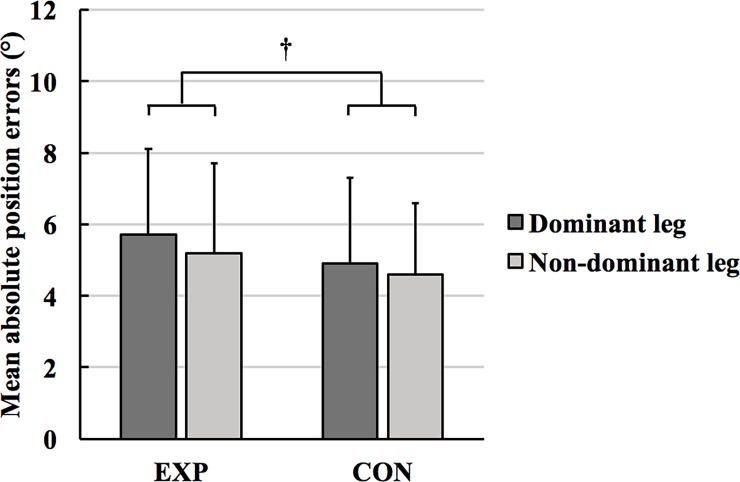
The effects of an above-knee compression garment (CG) on mean absolute position errors at the knee joint.Participants performed a position-matching task more accurately in the Control (CON) condition compared with the Experimental (EXP) condition, resulting in a significant effect of above-knee CG. † condition main effect (p = 0.014).